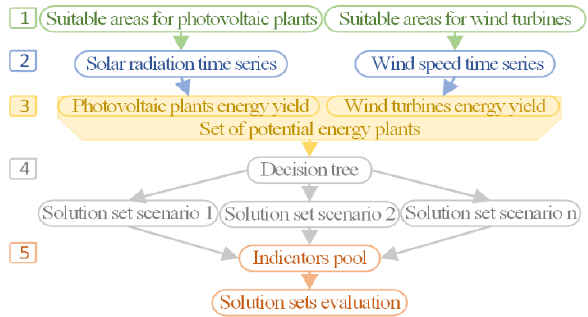
Figure 1. Overall workflow of the